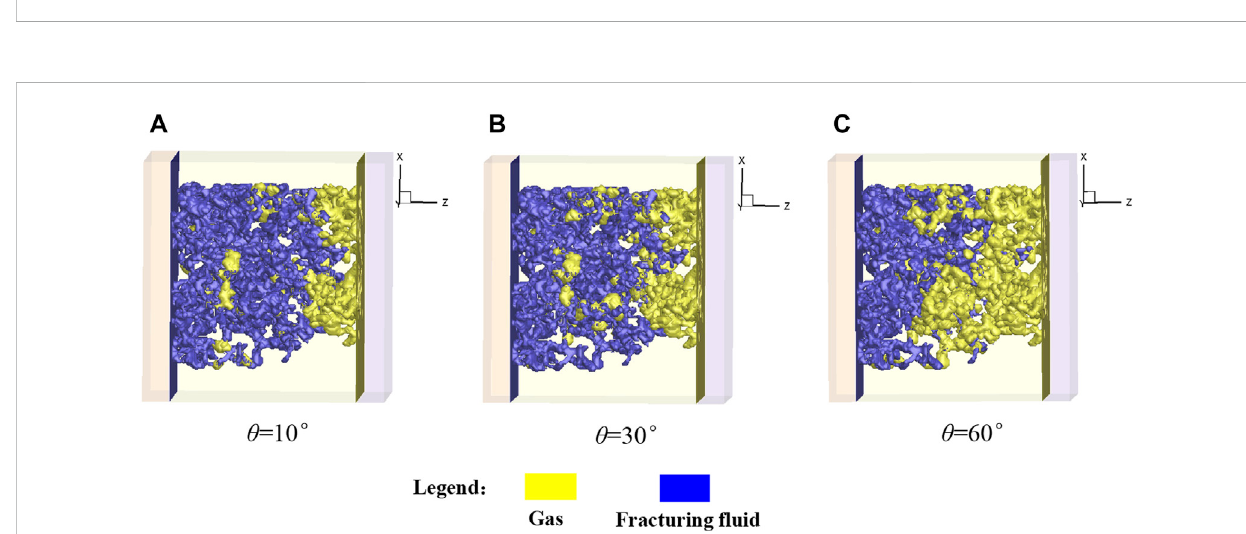
FIGURE 10 Gas-liquid distribution of slice 2 in Figure 9 at different time steps.